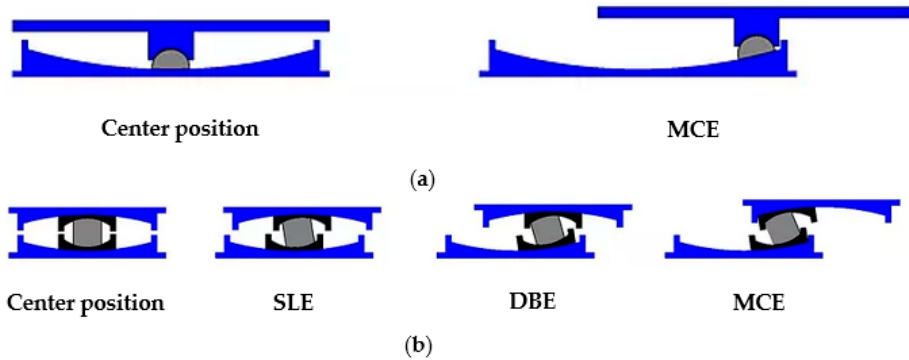
Figure 2. Performance levels for static conditions (left sketches) and various seismic scenarios (SLE = Service Level Earthquake, DBE = Design Basis Earthquake and MCE = Maximum Credible Earthquake) for: ( a ) SFPB and ( b ) TFPB (Reprinted from Computers and Structures, Volume 243, Alexandros Tsipianitis and Yiannis Tsompanakis, Optimizing the seismic response of base-isolated liquid storage tanks using swarm intelligence algorithms, Pages No. 106407, Copyright (2022), with permission from